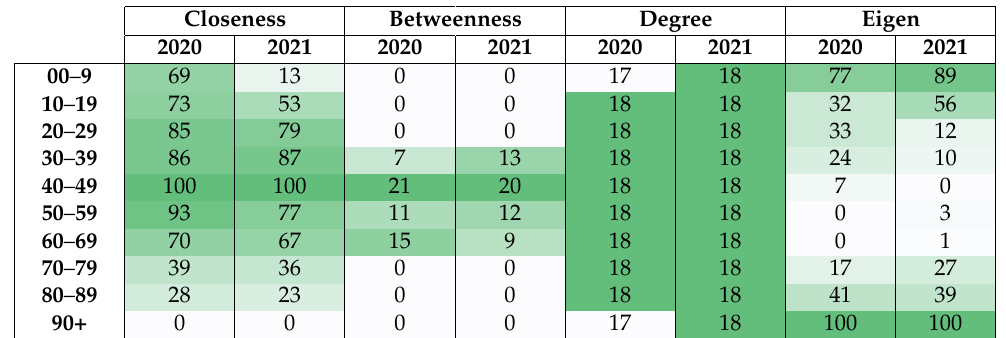
Table 5. Centrality measures of the digraph related to the age groups data for 2020–2021. Closeness Betweenness Degree Eigen